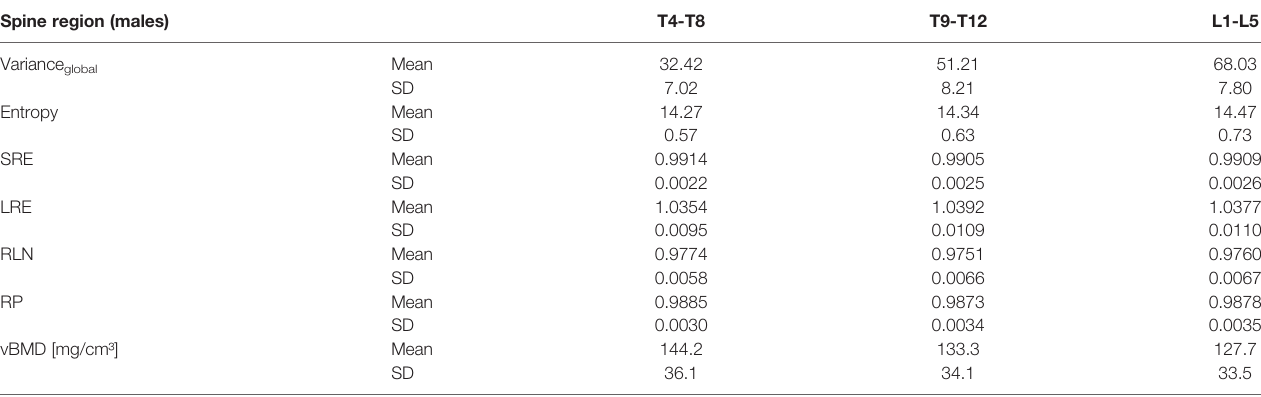
TABLE 5 | Mean and standard deviation (SD) of the six analyzed texture features and vBMD of males, grouped by spine region. Spine region (males)